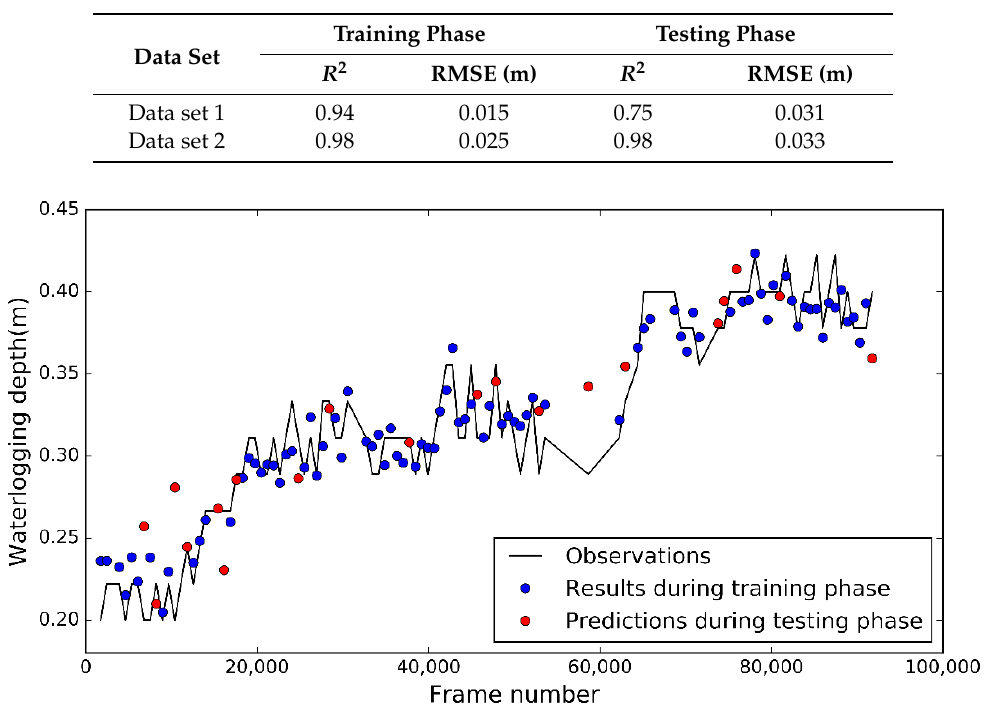
Figure 4. Observations vs. results and predictions during the training and testing phases for data set 1.